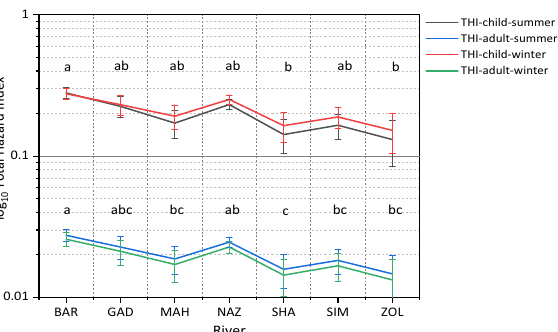
Figure 6. The comparison of the mean total hazard index of selected heavy metals between summer and winter for children and adult in the study rivers sediments. Different letters represent significant differences in Total Hazard Index among rivers pooled over seasons at P < 0.05 confidence